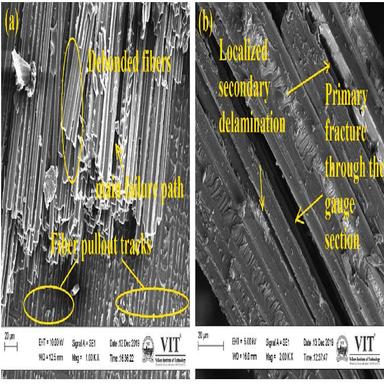
SEM images of flexural tested GFRP composites (a) neat epoxy GFRP (b) graphene reinforced GFRP composites.